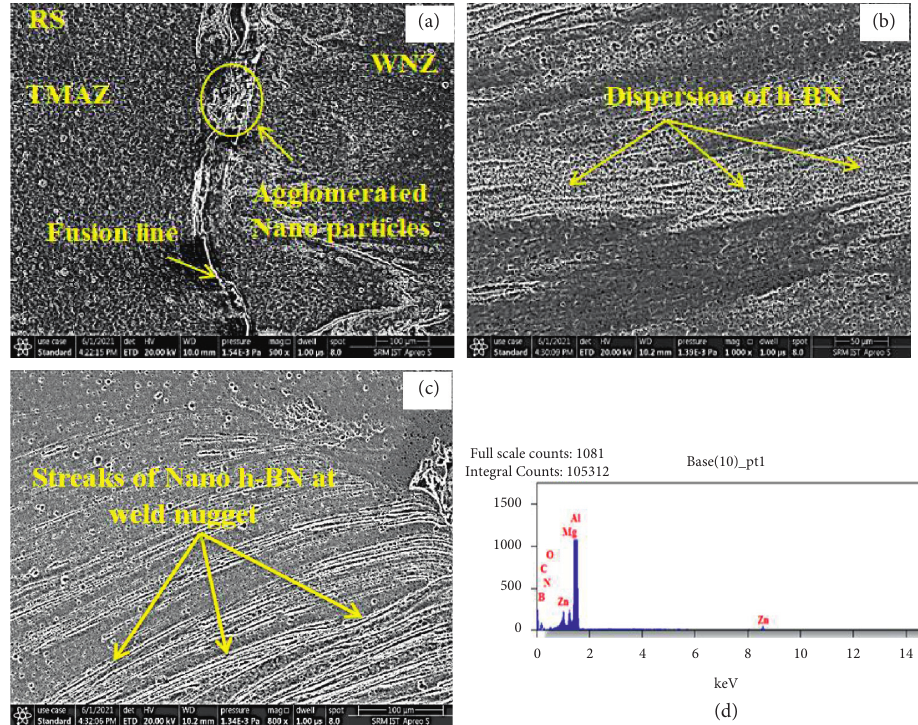
Figure 10: FESEM graphs of (a) interface zone, (b) nugget center, (c) nugget bottom, and (d) EDS graph. Table 7: EDS-based chemical composition. Element Weight